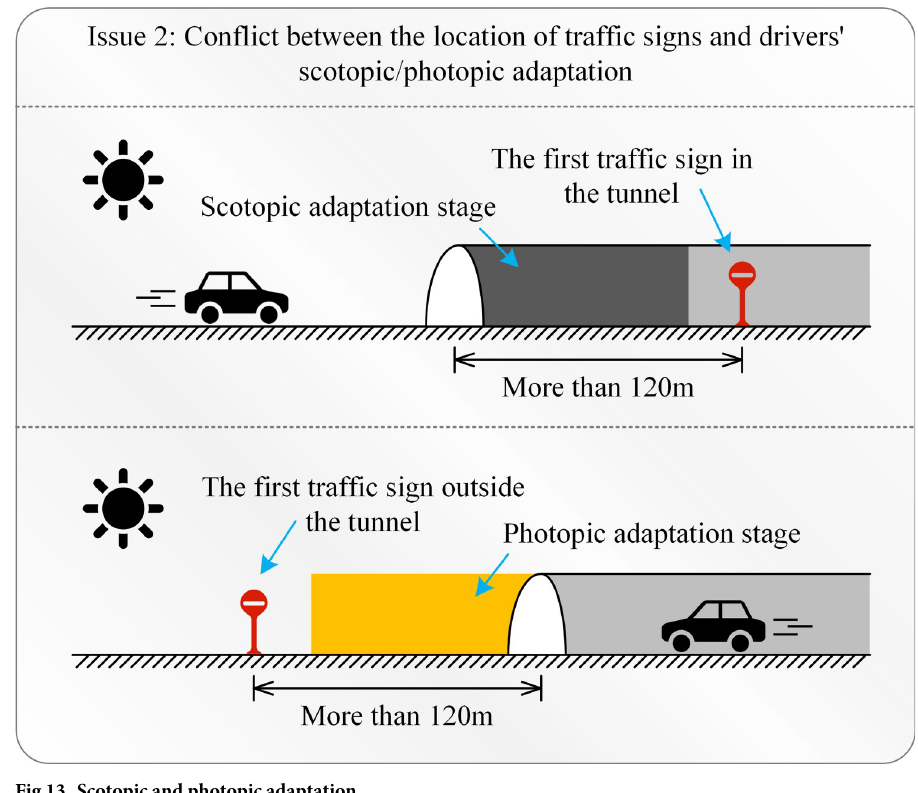
Fig 13. Scotopic and photopic